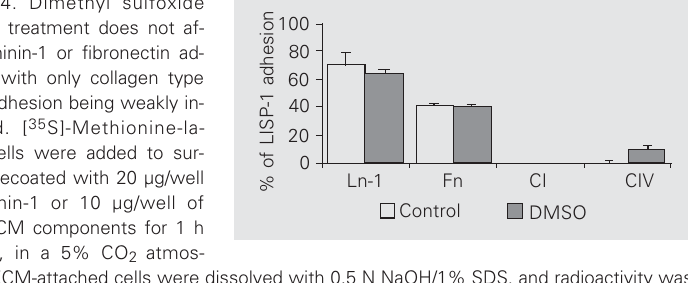
Figure 4. Dimethyl sulfoxide (DMSO) treatment does not